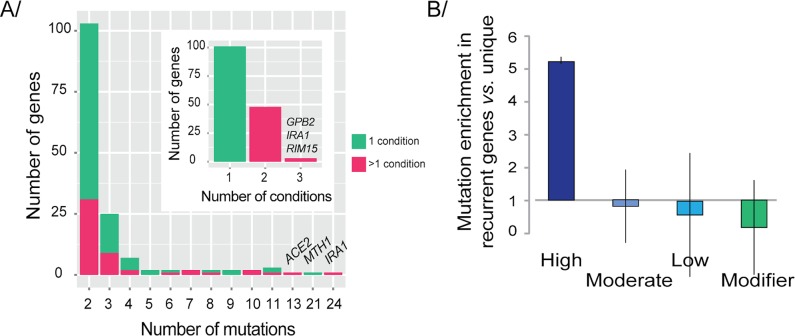
Recurrently mutated genes reveal how evolution is constrained.(A) Repeatability of adaptation and parallelism at the gene level. Genes were classified by the number of mutations detected during Evolve and Resequence studies: 154 genes were mutated in more than one sample; 48 genes with recurrent mutations were mutated in more than one condition (small panel). (B) Enrichment of recurrently mutated genes with high-impact mutations compared with genes mutated in only one sample. Enrichment is not observed for moderate or low impact mutations, or modifiers. Error bars are 95% CIs.